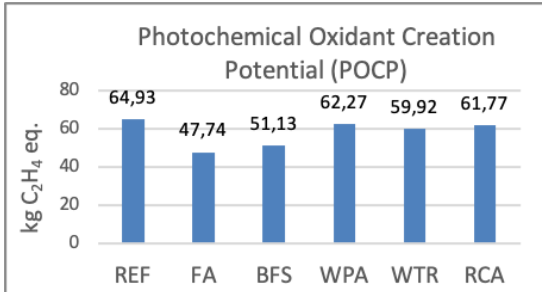
Figure 3. Comparison of the concrete frames regard- ing